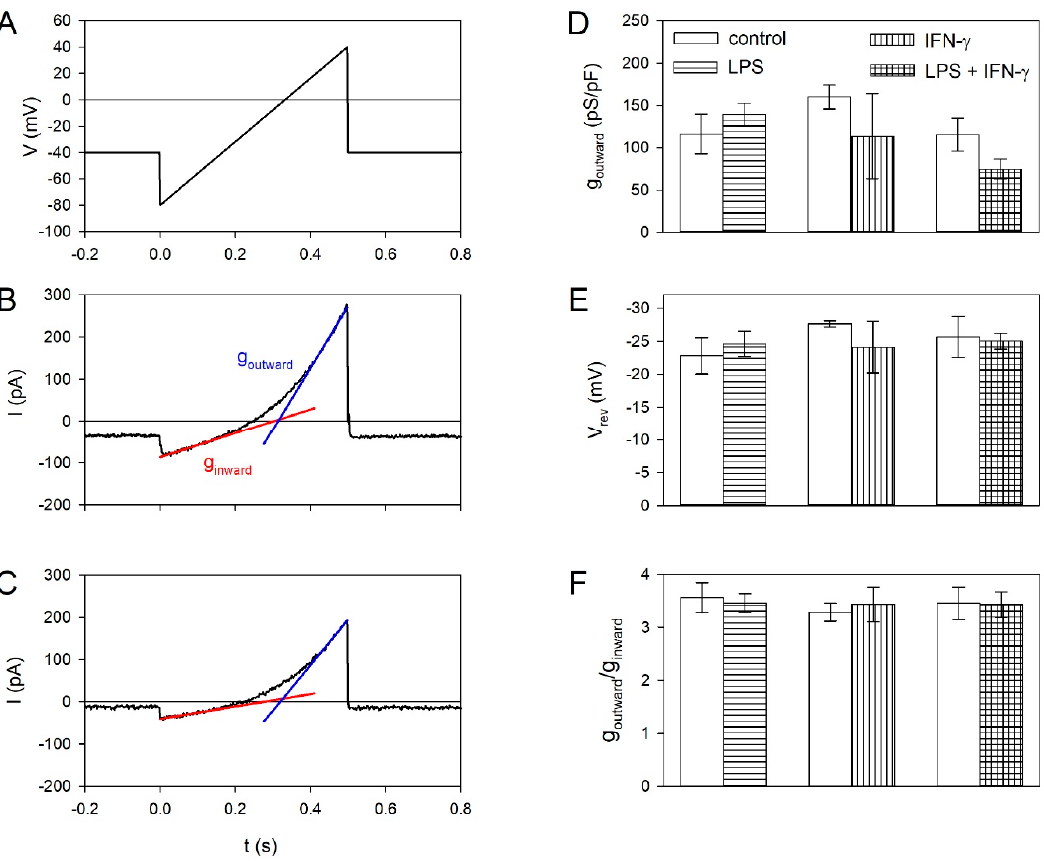
Figure 8. Effect of pro-inflammatory mediators on volume-regulated anion channels (VRACs). ( A ) Ramp protocol. ( B ) Representative ramp currents of control BV-2 cells and ( C ) BV-2 cells following 24 h of incubation with LPS and IFN- γ . The linear approximation to the inward and outward conductance is shown. Dependence of the outward conductance ( D ), the reversal potential V rev ( E ) and the outward rectification ( F ). The assignment of the different column fillings are included in ( D ). Means ± SEM of 6–10 cells.